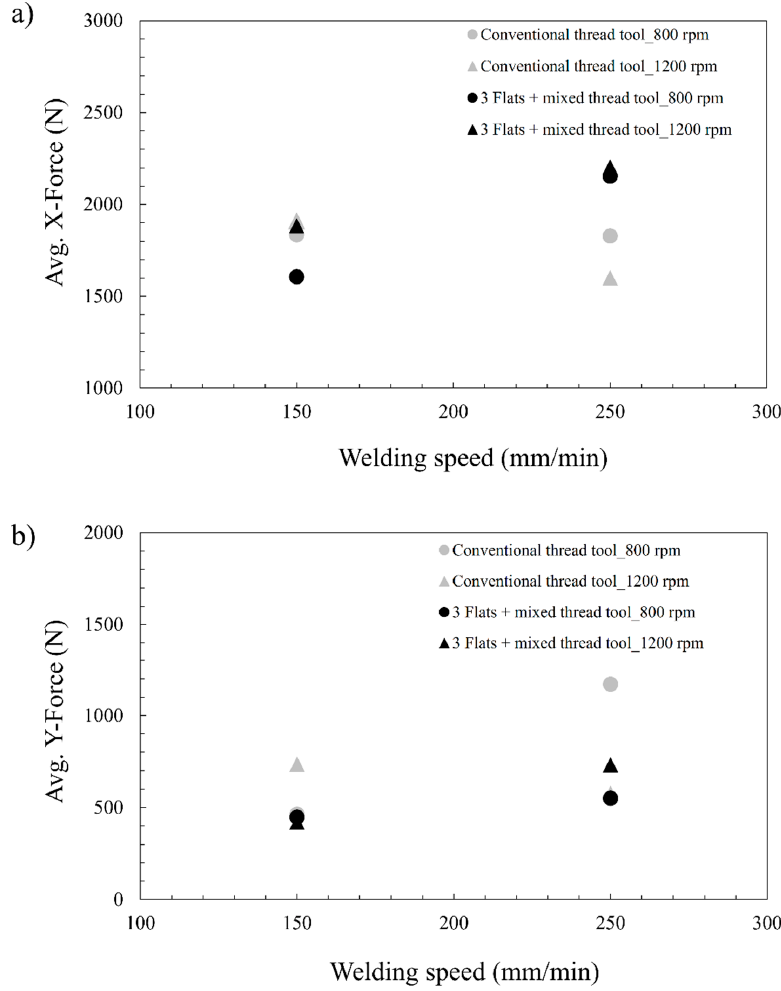
Figure 9. ( a ) Average X-Force and ( b ) average Y-force as a function of welding speed for the studied tool geometries and rotational speeds.